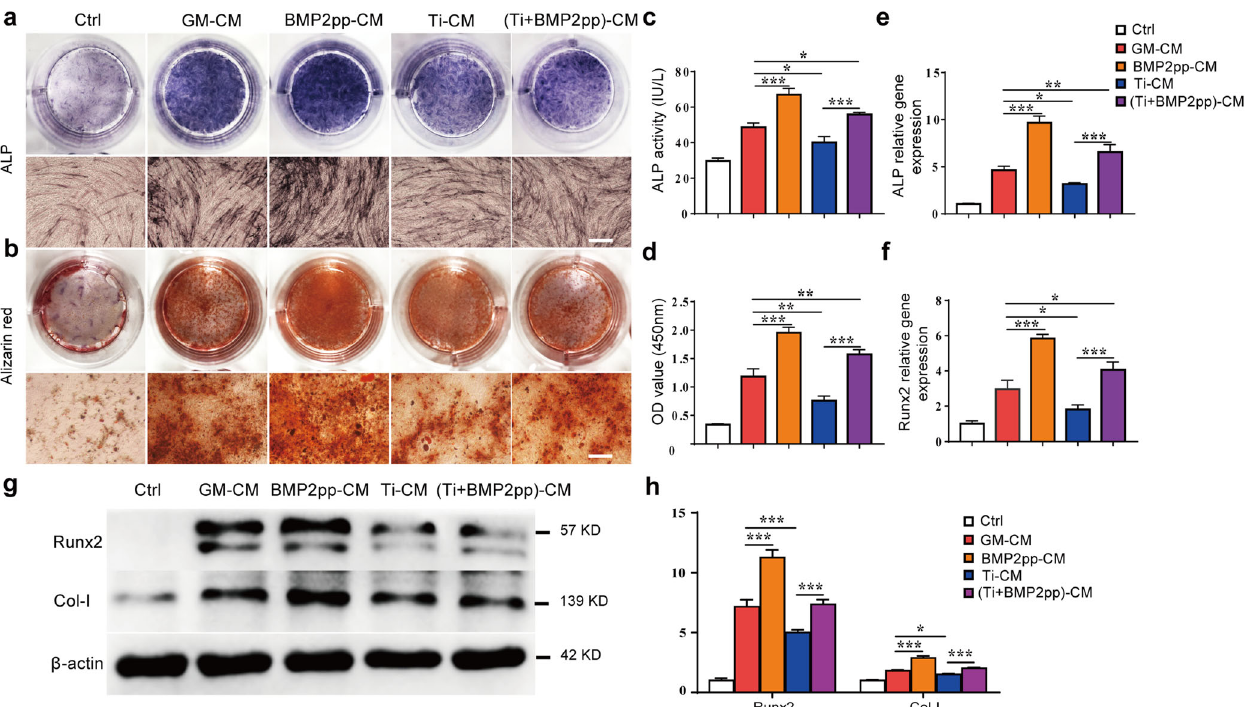
Fig. 3 BMP2pp indirectly enhanced the osteogenesis of hPMSCs by regulating macrophage polarization. a , b General (top) and microscope images (bottom) of ALP (7 days) and ARS (14 days) staining of hPMSC-derived osteoblasts with different conditional mediums. Scale bars: 200 μ m. Quantitative analysis of c ALP activity, and d ARS staining. e , f ALP/Runx2 gene expression of hPMSC-derived osteoblasts. g Expression of osteogenic-related proteins, including Runx2 and Col-I in hPMSCs cultured in the different mediums. h The relative gray levels correspond to Runx2 and Col-I. All the data are presented as the average ± standard deviation